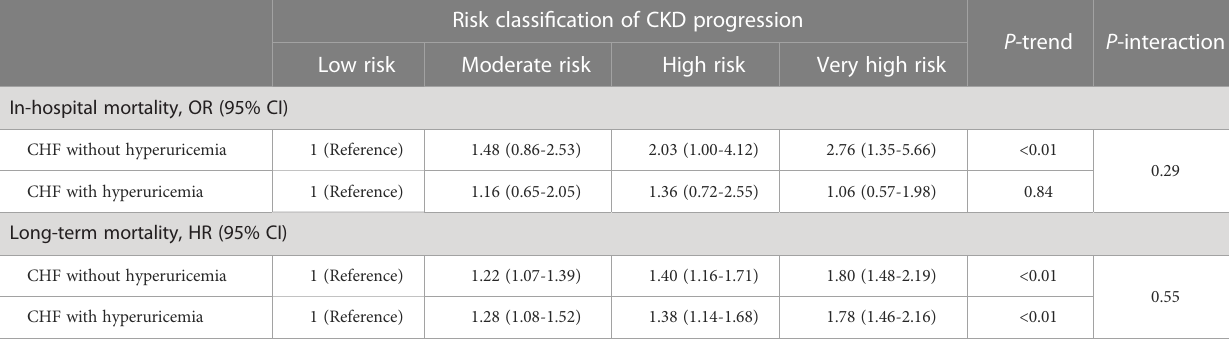
TABLE 4 Mortality risk grouped by risk classi fi cation of CKD progression and strati fi ed by